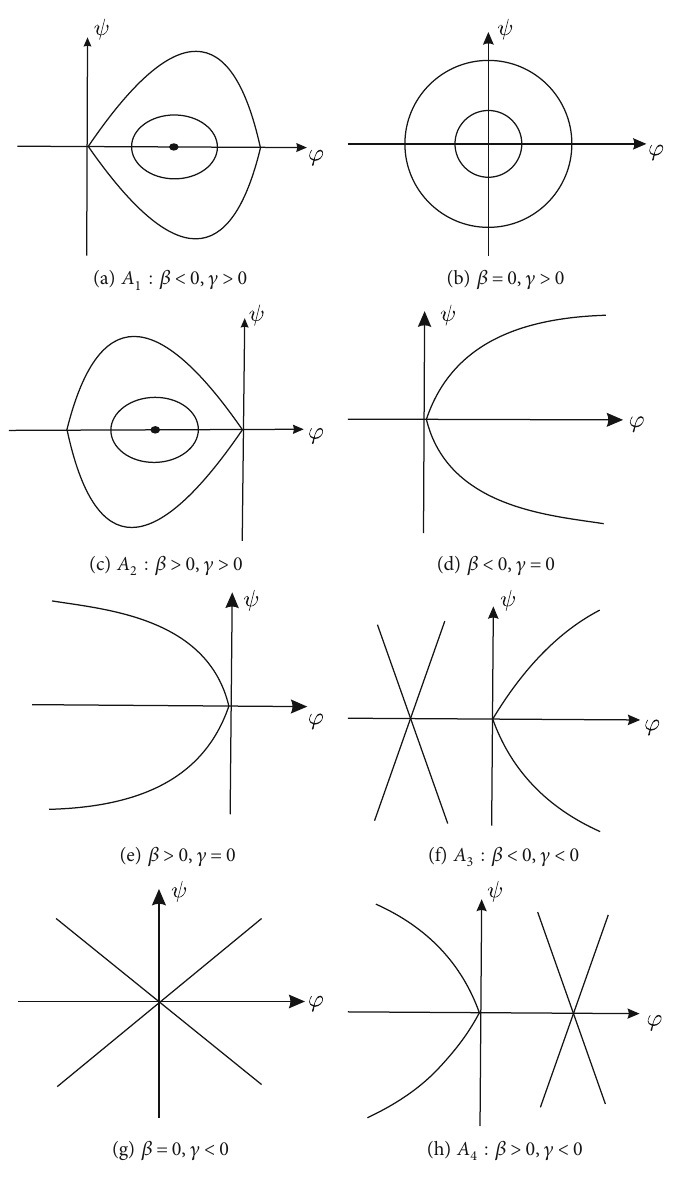
Figure 1: The phase portraits of the system